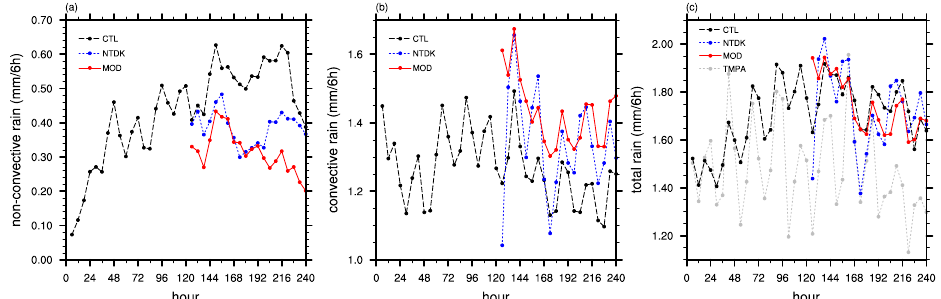
Figure 8. Time series of the six-hourly ( a ) grid-scale, ( b ) convective, and ( c ) total precipitation rates averaged over the selected domain (100° E–160° W, 0–50° N) from the CTL (black dashed), NTDK (blue dotted), and MOD (red solid) experiments. The dotted gray line in ( c ) shows the averaged TMPA precipitation rate.